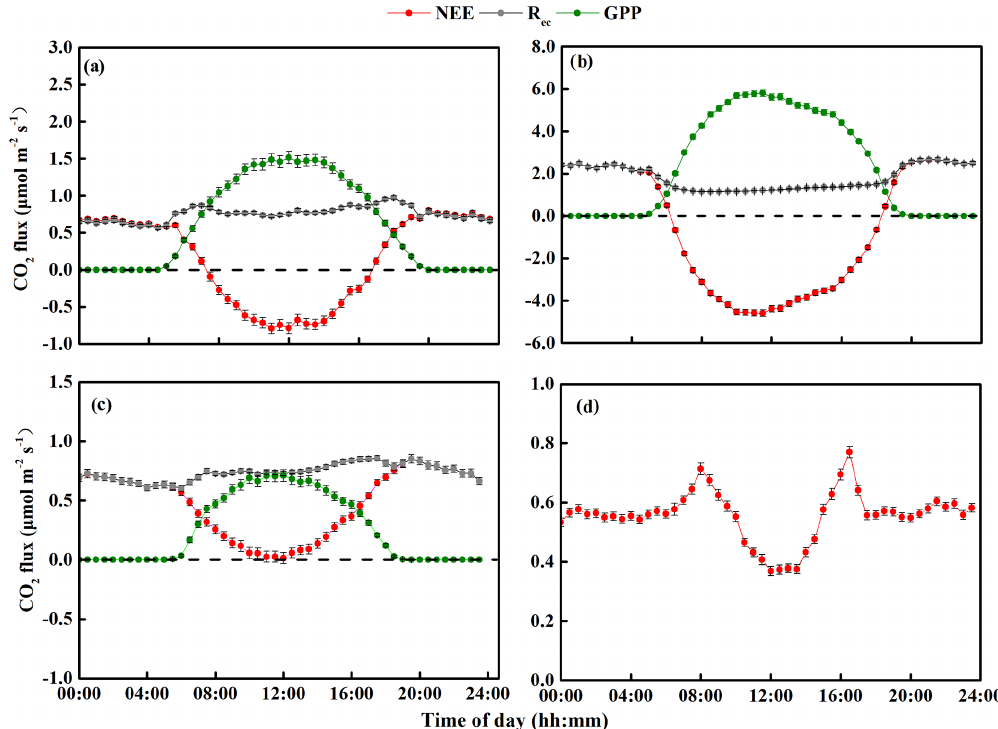
Figure 5. Diurnal changes in mean net ecosystem CO 2 exchange (NEE), gross primary productivity (GPP), and ecosystem respiration ( R ec ) from 2014 to 2018: (a) spring (March–April–May), (b) summer (June–July–August), (c) autumn (September–October–November), and (d) winter (December–January–February). Note that the y -axis scales differ greatly between the graphs and that the initial measurements were from 15 September to 23 December 2014, so the spring and summer data in this year do not include the period before 15 September. The final measurements were obtained on 31 December 2018, so the winter period from 2017 to 2018 was only about one-third of the usual length (i.e., it did not include data from January and February 2019). The error bars for the mean carbon fluxes represent standard